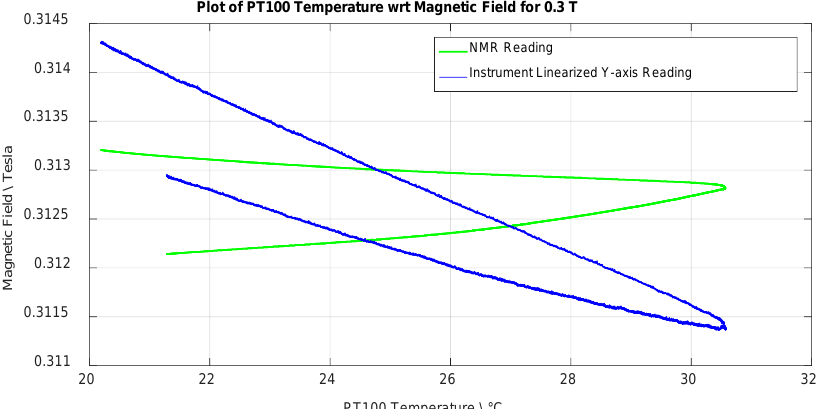
Figure 14. Graph showing the response of both the NMR and the instrument as the Hall probe is subjected to a field of 0.3 T and its temperature varied from 20 °C up to 31 °C using a Peltier element. An error plot for each of the six operating magnetic field points was extracted and are shown superimposed in Figure 15. As the reference ambient temperature was 24 °C, at which nonlinearity compensation is performed, the error plots in Figure 15 are supposed to cross each other with a null error at this temperature. However, limitations in the physical setup during the calibration procedure yielded such errors.